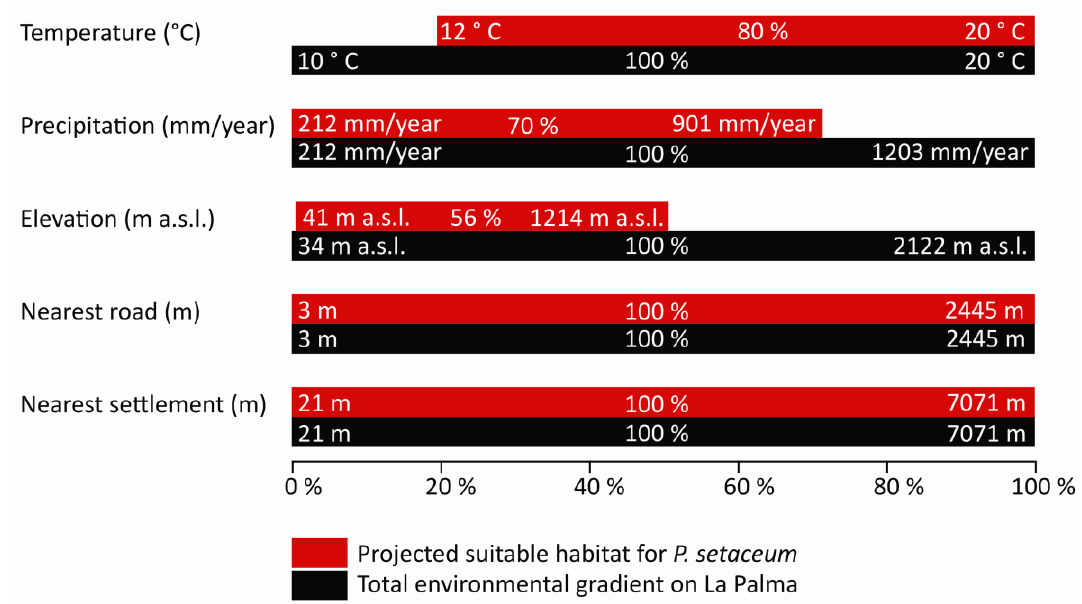
Figure 5. Total environmental gradients of mean annual temperature, annual precipitation, elevation, nearest road, and nearest settlement on La Palma (black bar). Red bars show the range of the environmental gradients projected to represent a suitable habitat for P. setaceum on La Palma. Note that the gradients elevation, nearest settlement, and nearest road do not start at zero due to calculations made on the bases of mean values for pixels the size of 500 × 500 m.